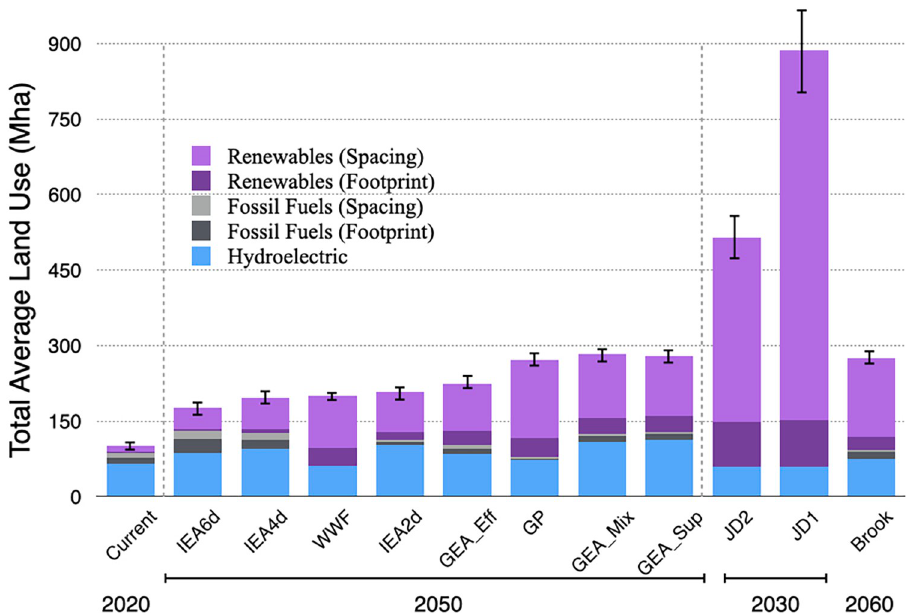
Fig 3. Land area (Mha) for future electricity generation scenarios, broken down by source of land use: Hydroelectric, fossil fuels, non-hydro renewables, and spacing from wind and natural gas. Land use for biomass electricity is included in non-hydro renewables, but we assume all biomass comes from residue or waste for these calculations, thus representing a lower bound. JD1 refers to the Jacobson & Delucchi scenario assuming all wind is onshore, and JD2 assumes 50% of wind is onshore and 50% is offshore. Total land required to generate electricity in each future decarbonization scenario is shown with standard errors. GEA_Sup, GEA_Eff, and GEA_Mix are the GEA Supply, Efficiency, and Mixed scenarios respectively. Electricity generation data for the current mix (2017) comes from the BP Statistical